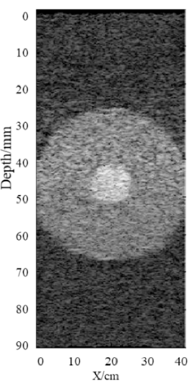
Figure 9. The compensated image with adaptive TGC.